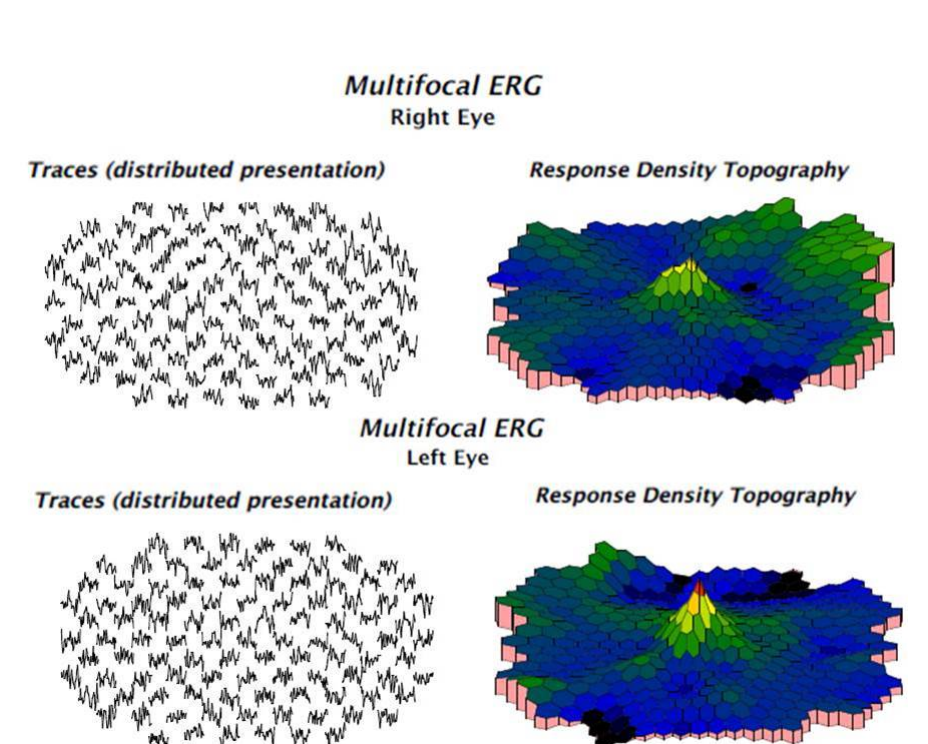
Figure 3: Reduced foveal, parafoveal and perifoveal responses noted in multifocal electroretinogram